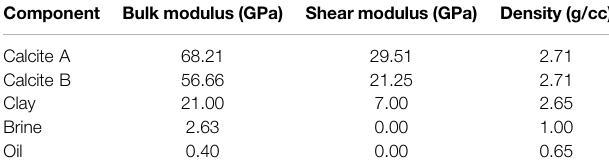
TABLE 2 | The elastic moduli and densities of the rock